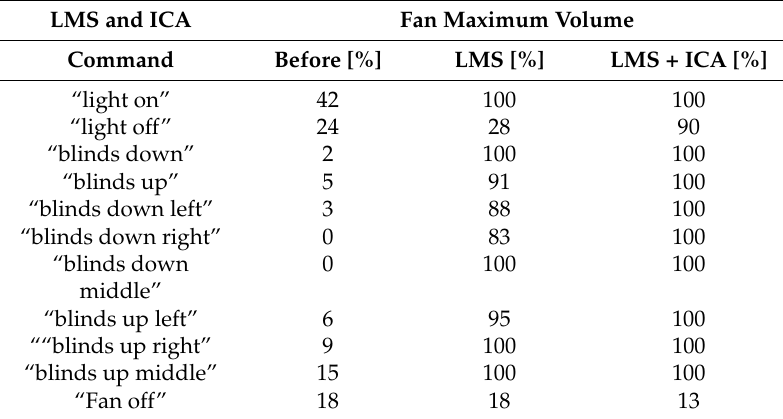
Table 8. The results of recognition success rate for fan interference.